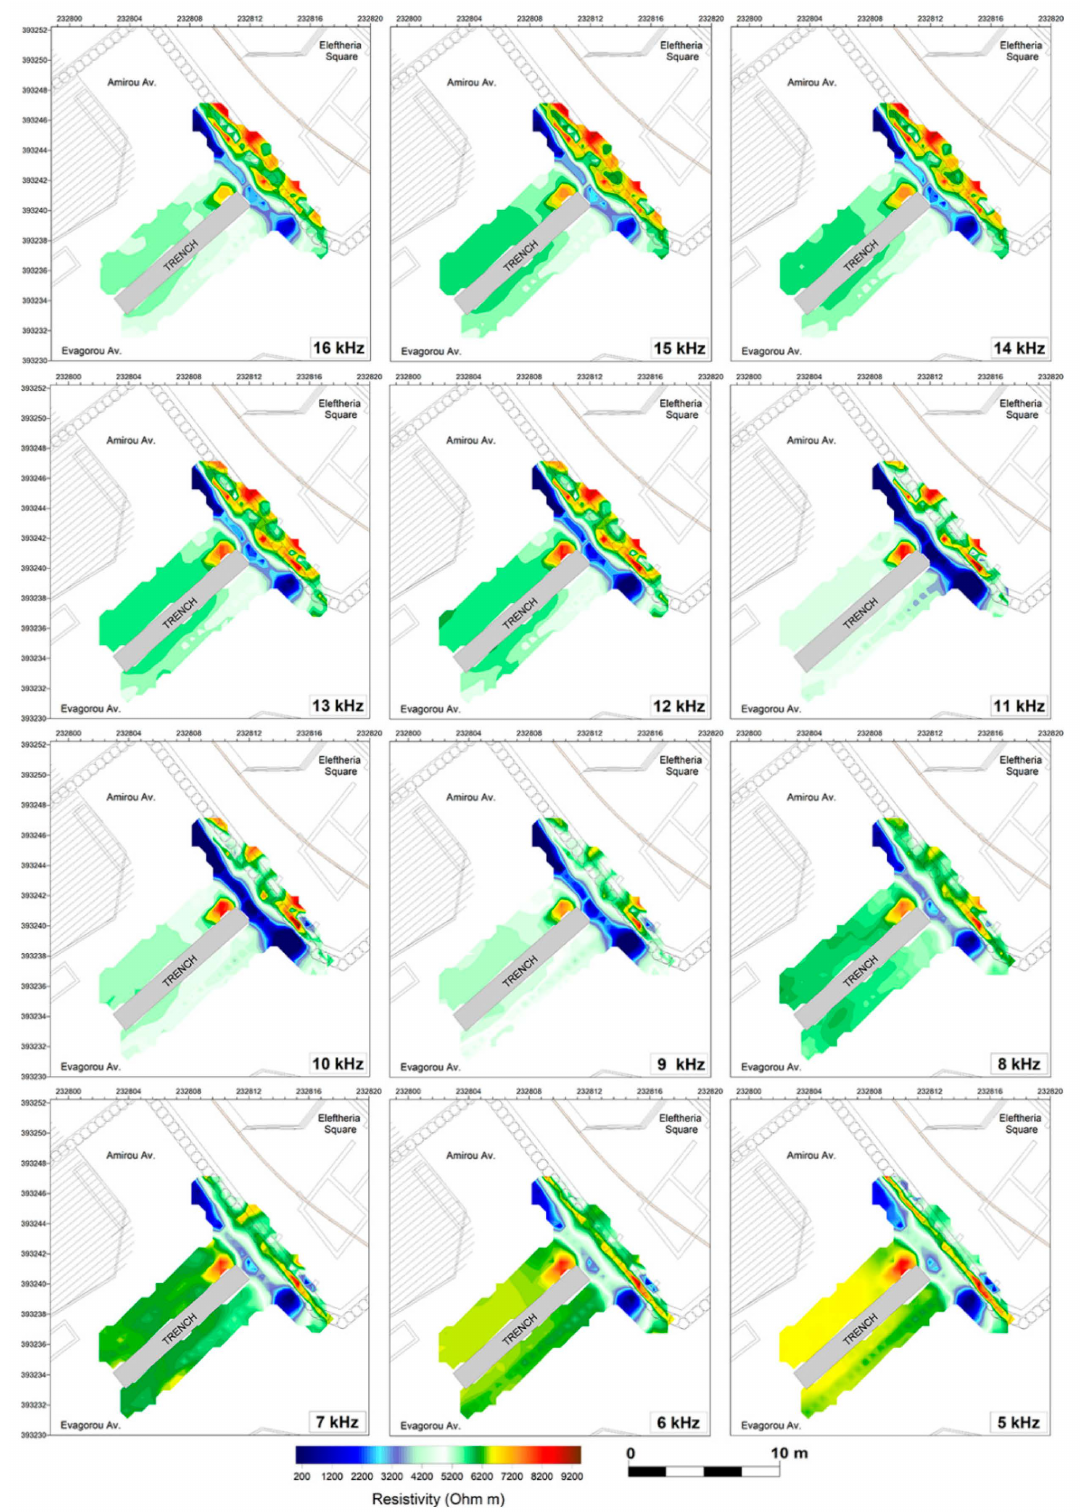
Figure 13. EMI resistivity maps relative to the frequencies in the range 16–5